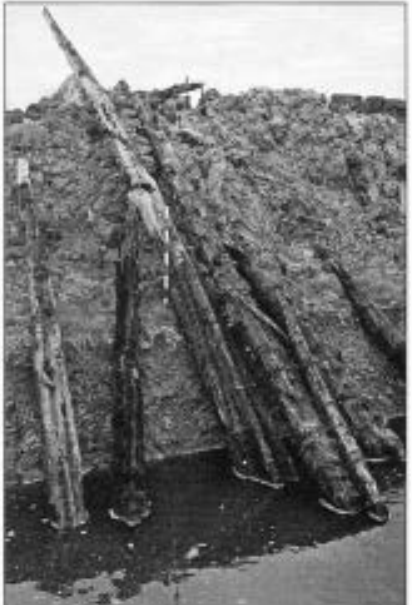
Figure 2 Remains of yew trees of Early Bronze Age date recovered from an exca­ vation along the line of the A13 road at Wennington Marsh on the border of Lon­ don and Essex (scale bar intervals 10 cm).